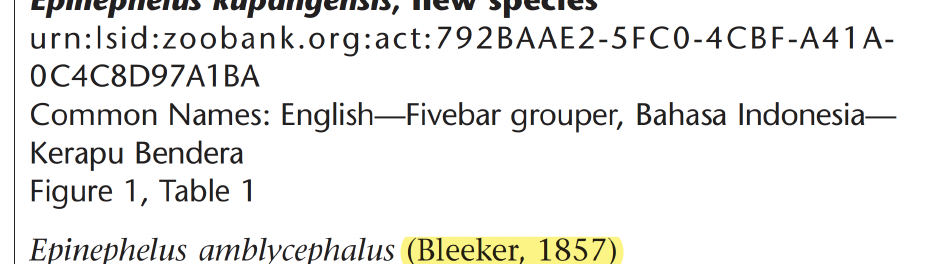
Fig. 12. Here “Bleeker, 1857” is considered by the authors as a bibliographical reference and listed as such under the references section although it has not been cited elsewhere in the text (Tucker et al.